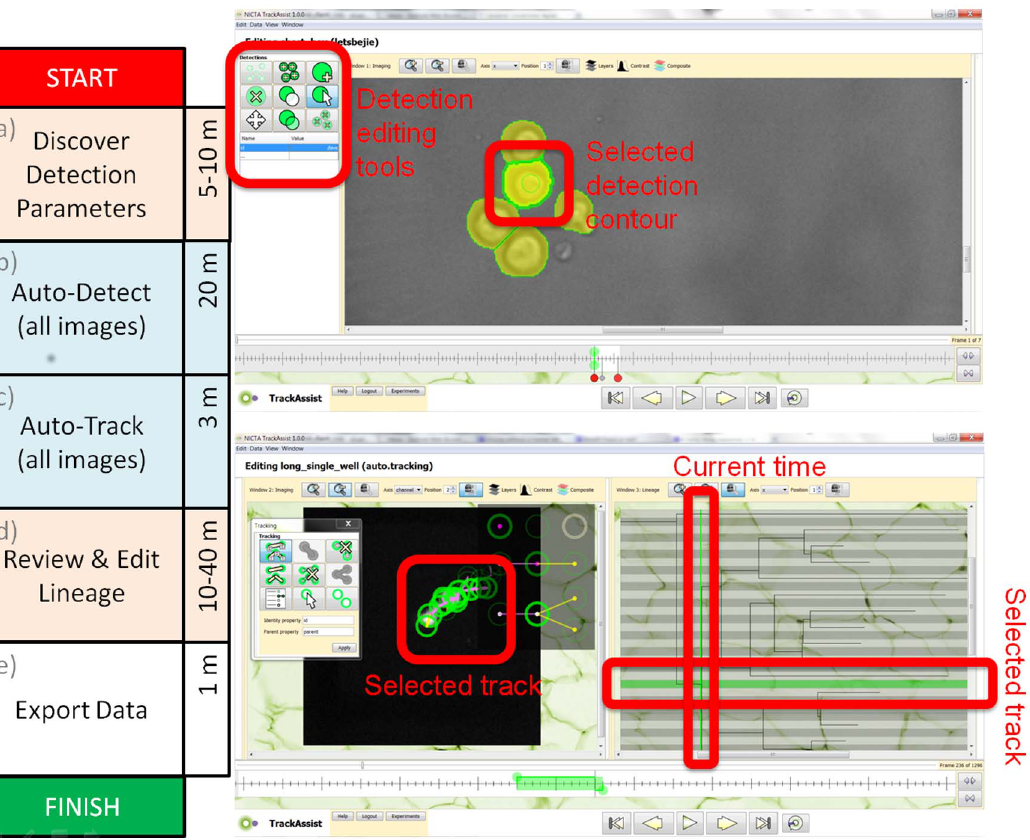
Figure 1. Workflow for the processing of a population of cells in a single microwell, resulting in a pedigree analysis. Data produced includes contours, tracks and lineage for all cells in all images. The timeline on the left shows tasks in order and the average time required for the results in this paper. The blue areas are automated tasks, with no user interaction required. Pink areas are manual operations. On the right side of the figure are two screenshots of the user interface during the two time-consuming manual tasks. Top: Automatically segmented detections as shown during the process of evaluating segmentation parameters, overlaid on the bright field channel (NB: Fluorescence channel is used for segmentation, bright field allows user to validate). Below: track editing while simultaneously viewing the lineage context of each cell-detection. The selected track is highlighted in both imaging and lineage views. Both views update simultaneously in response to edits. The lineage tree allows users to find and fix suspicious division, death and track start events very quickly.